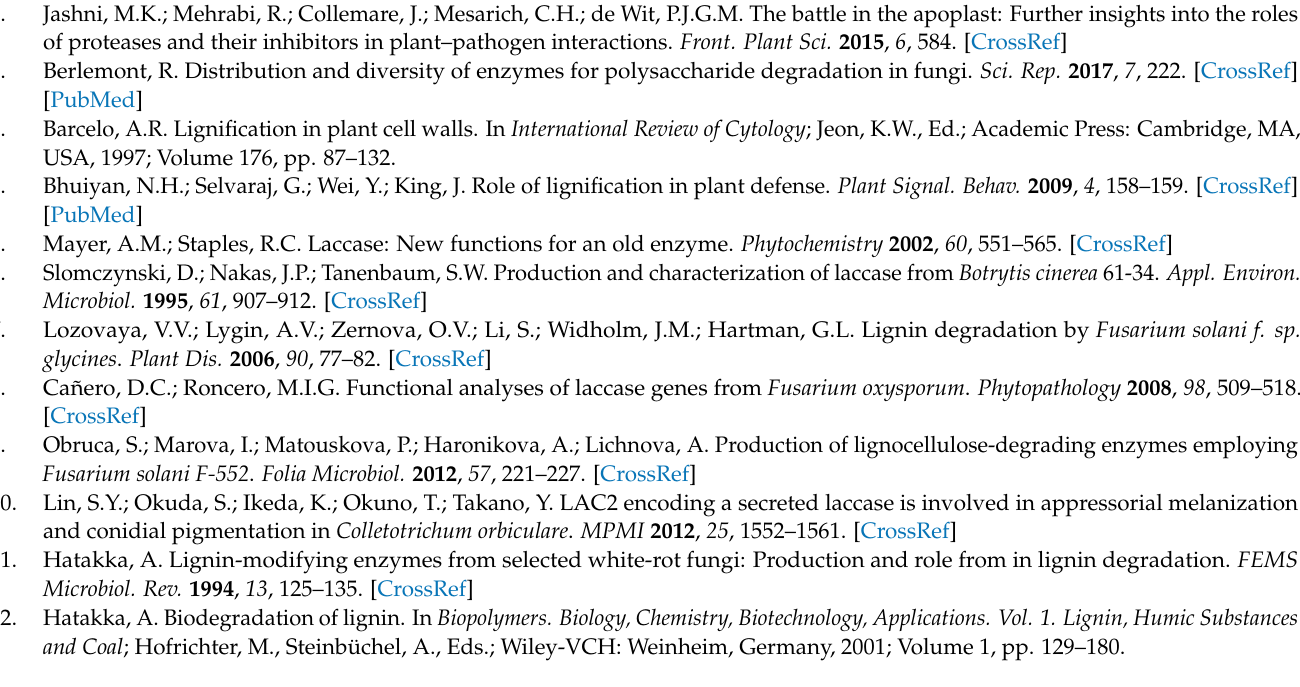
Table S3: The correlation analysis of the levels of extracellular phenol oxidase (lignin peroxidase,